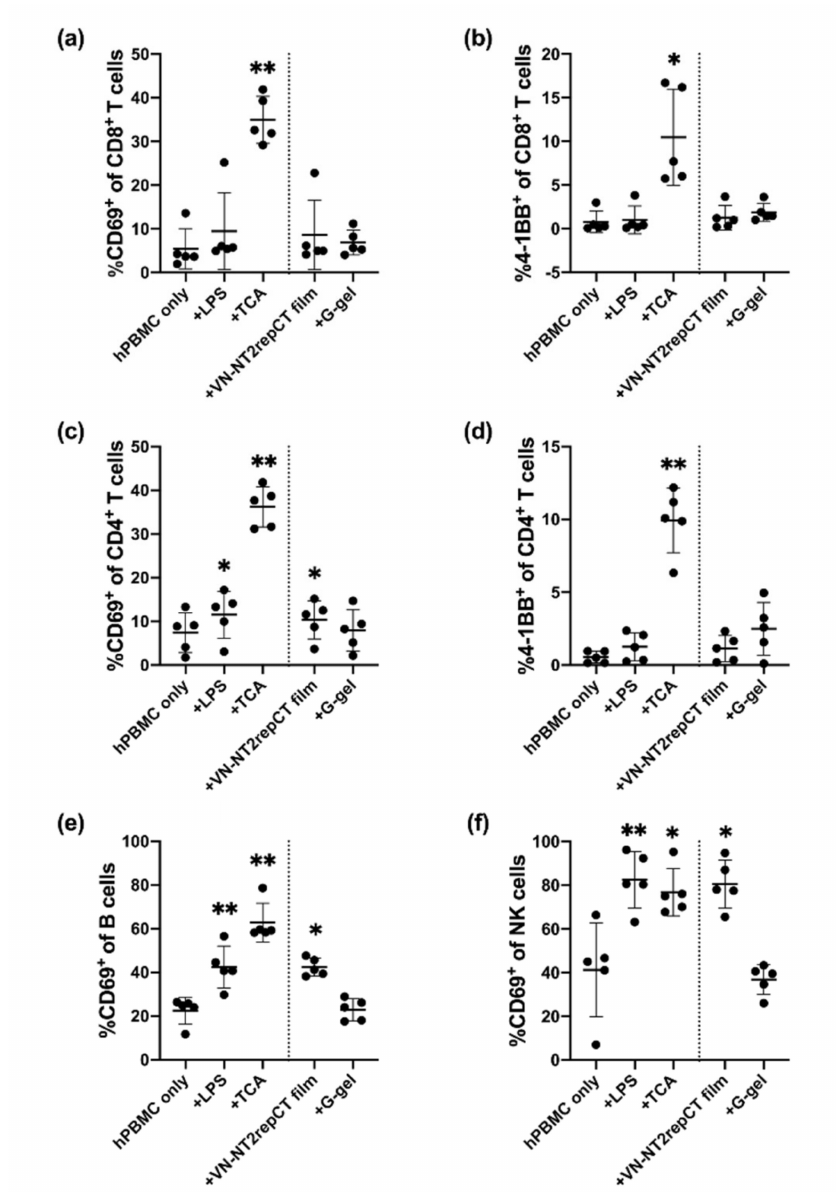
Figure 2. Activation of hPBMC lymphocyte subsets after being exposed to different biomaterials. hPBMCs were cultured for 15–18 h as hPBMC, only (baseline control); (hPBMCs) + LPS (positive control); (hPBMCs) + TCA (positive control); (hPBMCs) + VN–NT2RepCT film; and (hPBMCs) + Gran- ular HA hydrogel (“G-gel”). Thereafter, the expression of CD8, CD4, CD69 and 4-1BB was assessed by flow cytometry. The graphs show the percentages of ( a ) CD69 + out of all CD8 + T cells; ( b ) 4-1BB + out of all CD8 + T cells; ( c ) CD69 + out of all CD4 + T cells; ( d ) 4-1BB + out of all CD4 + T cells; ( e ) CD69 + out of all B-cells; and ( f ) CD69 + out of all NK cells. The gating for B cells (CD3 − CD56 − CD19 + ), NK cells (CD3 − CD56 + CD16 + ), CD4 + T cells (CD3 + CD4 + ) and CD8 + T cells (CD3 + CD8 + ) is described in Figure S2. Data are presented as mean ± SD, and each dot within a group represents hPBMCs from one separate biological donor. The vertical dotted line in the graph demarcates the control versus the experimental groups. The statistical test of mixed-effects analysis with Dunnett’s post hoc test was applied to compare the experimental groups with the hPBMC-only control. Statistically significant differences from the hPBMCs-only control are indicated as: * p ≤ 0.05, ** p ≤ 0.01. n = 5 biologically different hPBMC populations. Abbreviations: SD, standard deviation; TCA, T cell activation; G-gel, granular HA